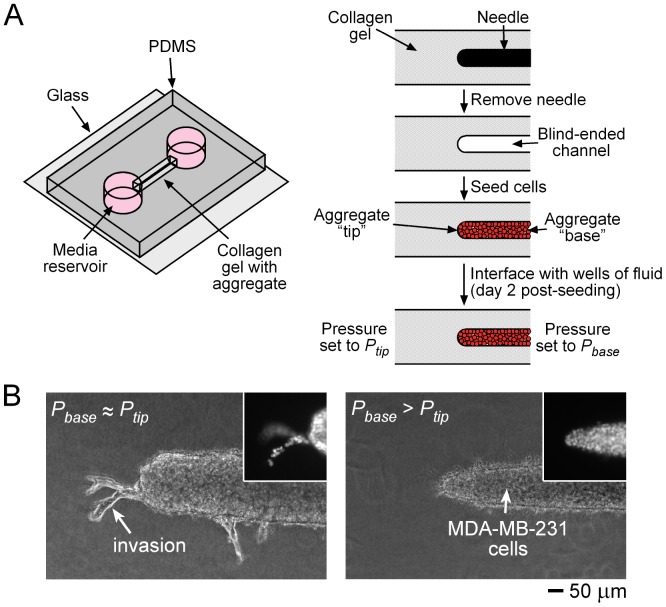
Formation of 3D micropatterned aggregates of MDA-MB-231 cells.(A) Schematic diagram of the completed experimental setup (left) and the procedure used to form single aggregates (right). Each aggregate consisted of a “base” that ended in a “tip” in a type I collagen gel. (B) Representative phase-contrast and fluorescence (insets) images of Hoechst-stained tips for Pbase equal to or greater than Ptip, seven days after establishing the pressure set-points.